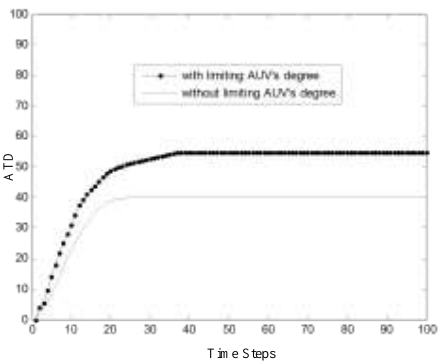
Figure 9. ATD vs. time step with and without limiting AUV's